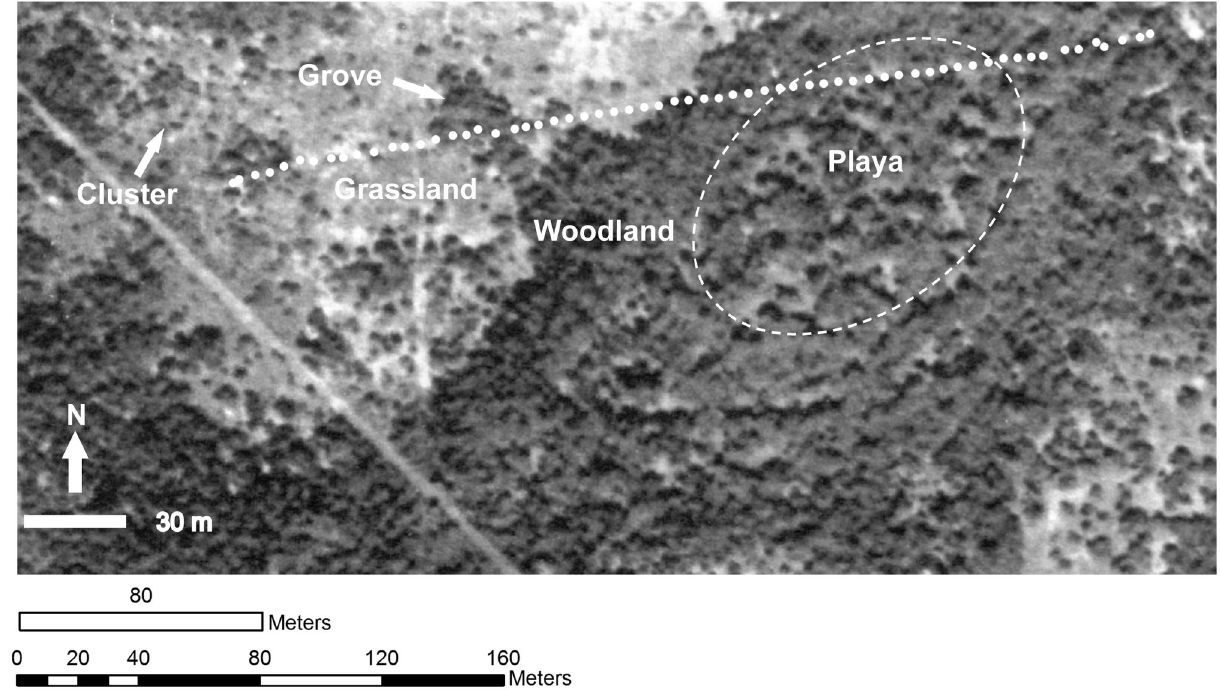
Figure 1. Aerial view of the study site showing a transect spanning shrub cluster and grove communities in savanna parkland uplands, a woodland community in an intermittent drainage, and a playa savanna community. Each of these communities is developing on former grassland. White dots are GPS locations at 5 m intervals. Dark and light gray colors indicate woody and herbaceous vegetation, respectively. Trees and shrubs were inventoried in contiguous plots (6 x 6 m and 2 x 2 m, respectively) along the